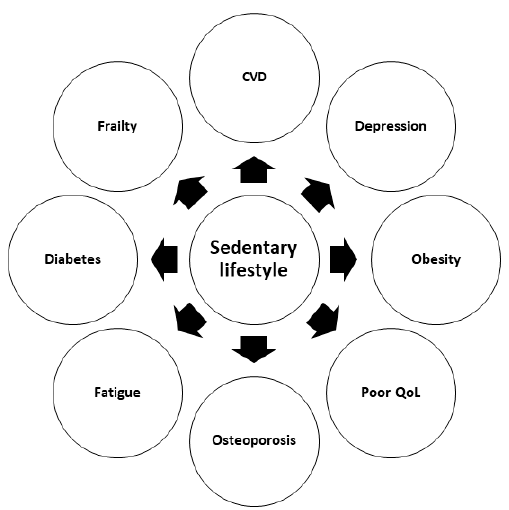
Figure 1. Negative effects of a sedentary lifestyle after kidney transplantation (CVD, cardiovascular disease; QoL, quality of life).